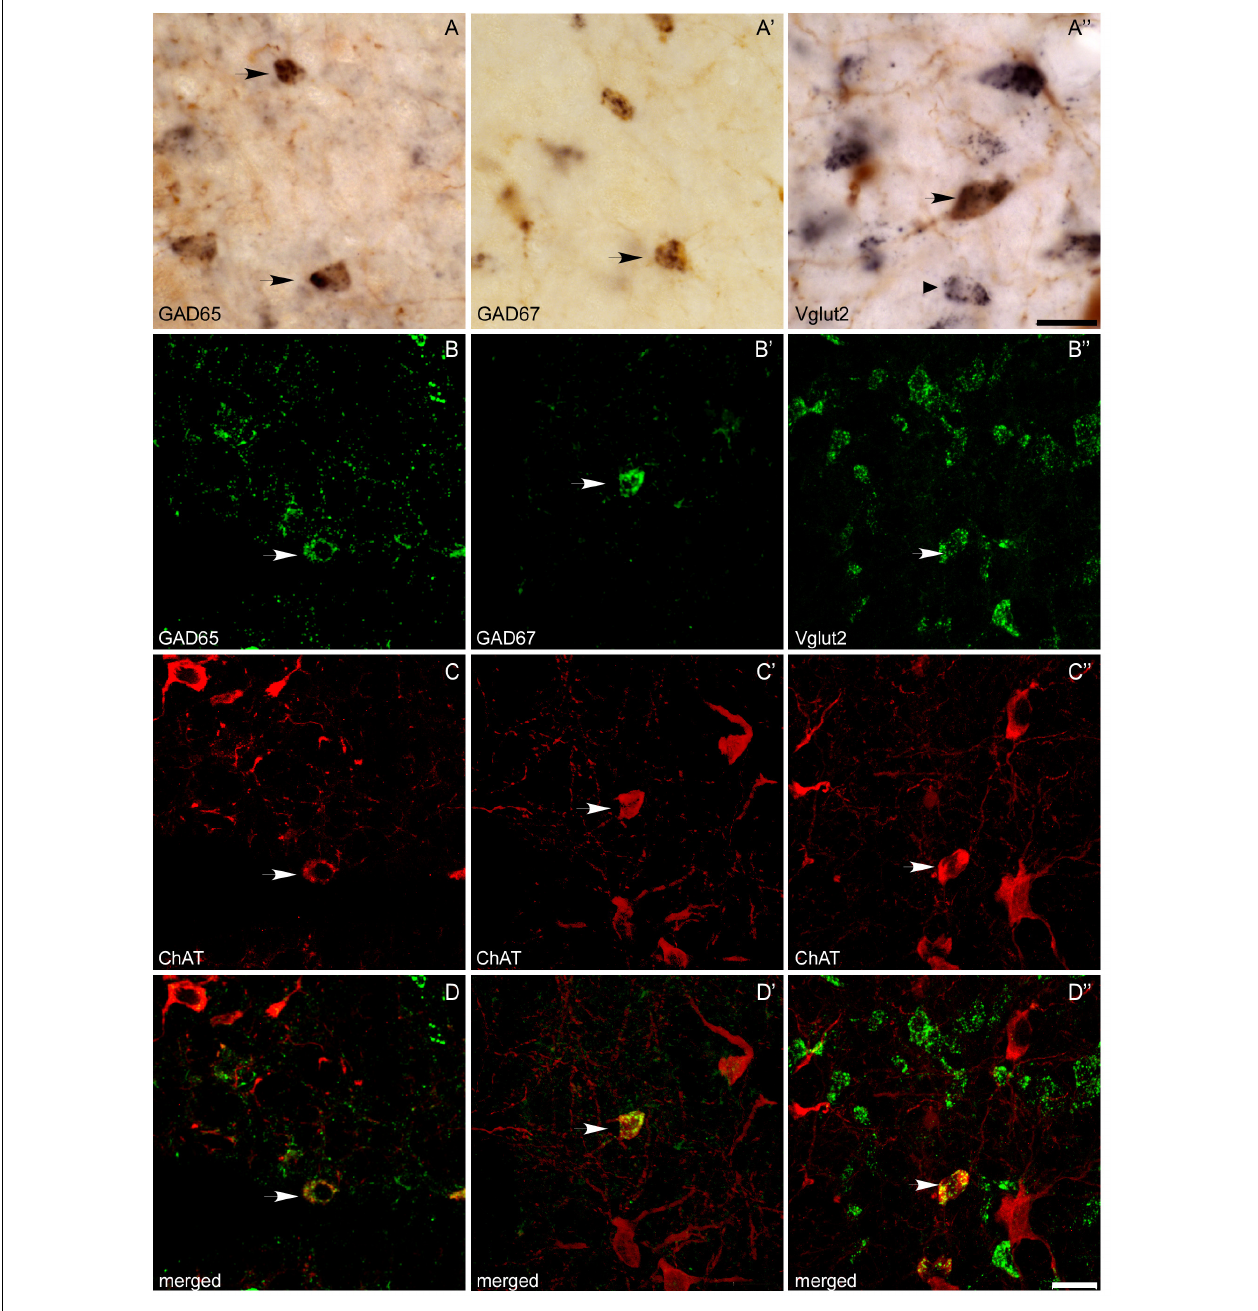
FIGURE 6 | Colocalization of ChAT immunoreactivity and GAD65, GAD67, or Vglut2 mRNA expression in the PPN and LDT. (A–A”) Microphotographs of colorimetric dual labeling taken at the magnification used for quantification (100 × ). Arrows mark potential dually labeled cells recorded during the stereological quantification, while a small arrow points to a single Vglut2-positive cell. Scale bar: 20 µ m. (B–D,B’–D’,B”–D”) Confocal images of immunofluorescence labeling, confirming the colocalization of ChAT immunoreactivity with either GAD65 (B–D) , GAD67 (B’–D’) , or Vglut2 (B”–D”) mRNAs, although the degree of colocalization was low. Scale bars: 20 µ